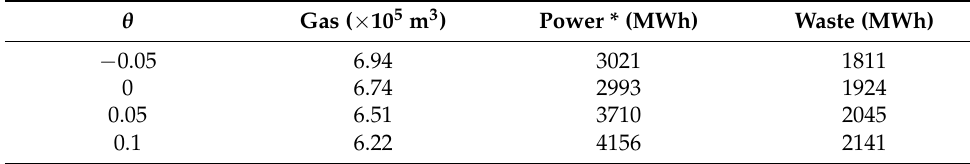
Table 6. The input and waste energy of the DES-HOS with a θ from − 0.05 to 0.1.